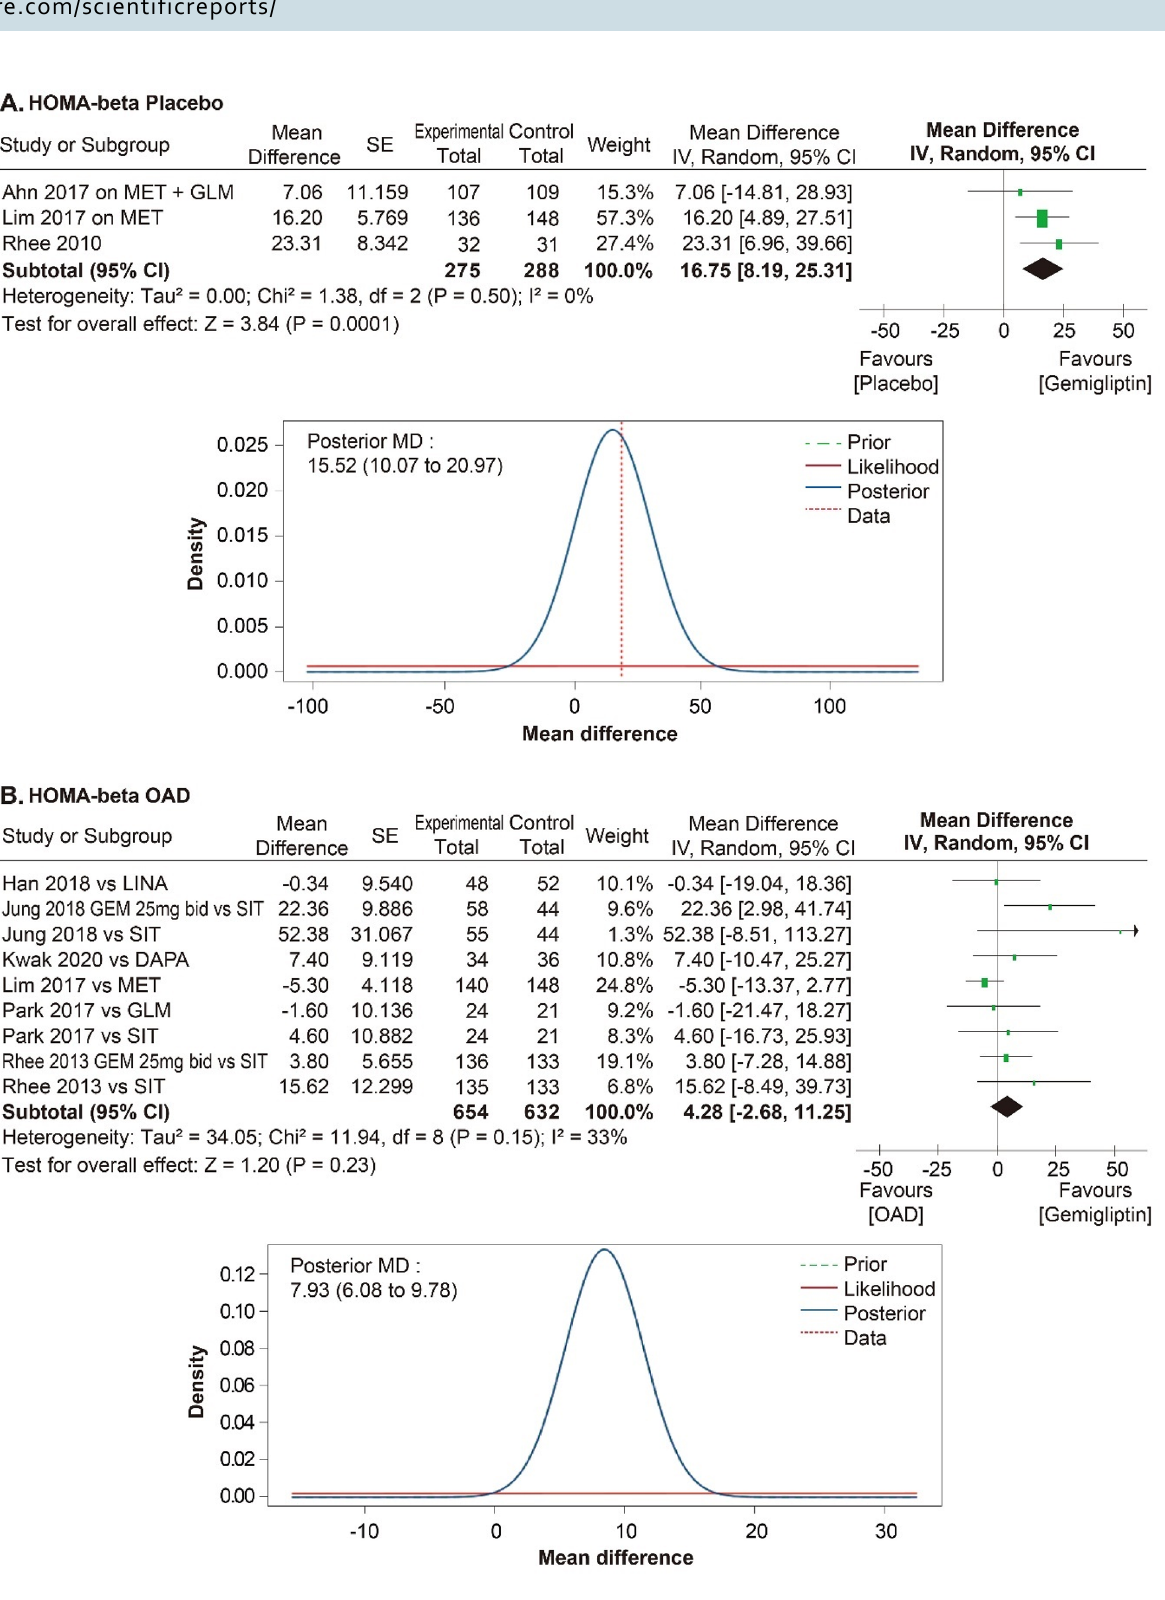
Figure 6. Forest plot of RCTs for the effect of gemigliptin on